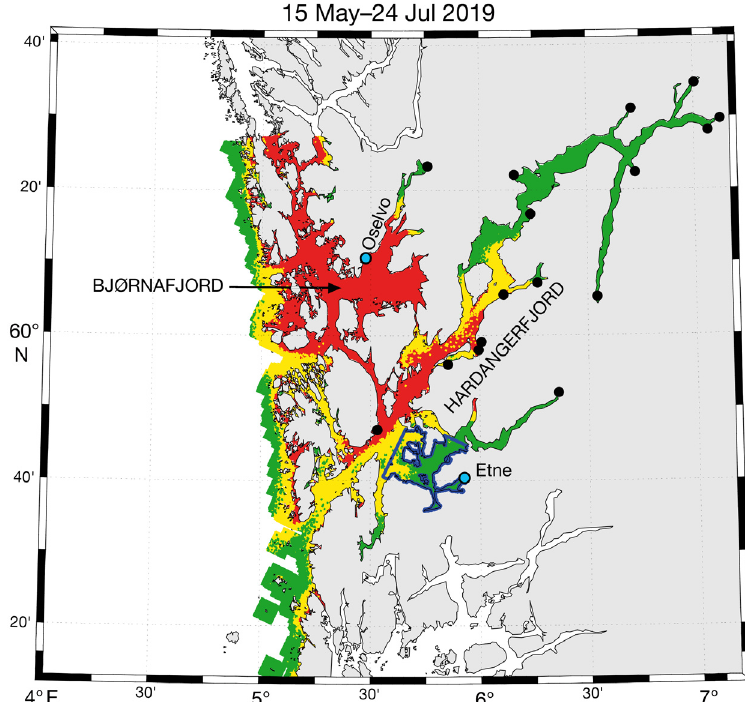
Fig. 1. A relative operating characteristic (ROC) map of PO3 showing where it is expected that intermediate sea trout smolt migrants (remaining in the area from May 15 to July 24) are infested with >18 mobile lice (red area), between 6 and 18 mobile lice (yellow area) and <6 mobile lice (green area). The location of the 18 sea trout rivers in the PO are marked with black dots, and the Oselvo and Etne rivers are marked with cyan dots. The marine living area for Etne sea trout, defined as 20 km from the home river mouth, is outlined in